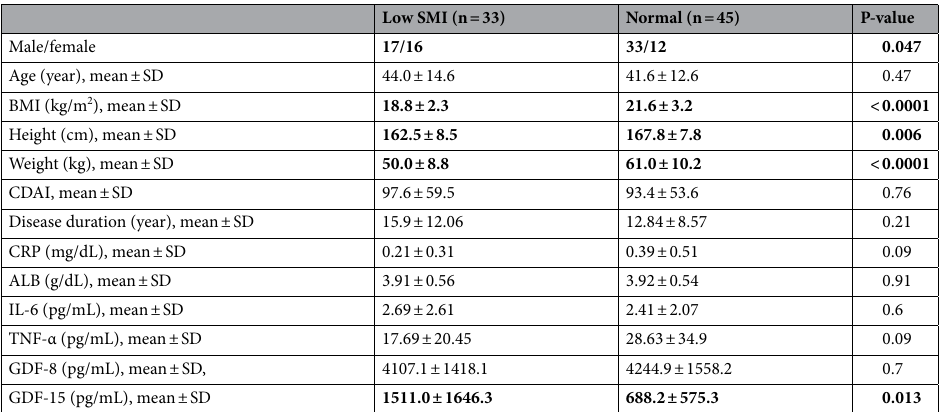
Table 3. Comparisons between the low SMI group and normal SMI group. Data was analyzed either by t test or χ 2 test. BMI body mass index, CDAI Crohn’s disease activity index, CRP C-reactive protein, ALB albumin, IL-6 Interleukin-6, TNF-α tumor necrosis factor-alpha, GDF-8 growth differentiation factor-8, GDF-15 growth differentiation factor-15, SD standard deviation, SMI skeletal muscle mass index. Significant values are in bold.